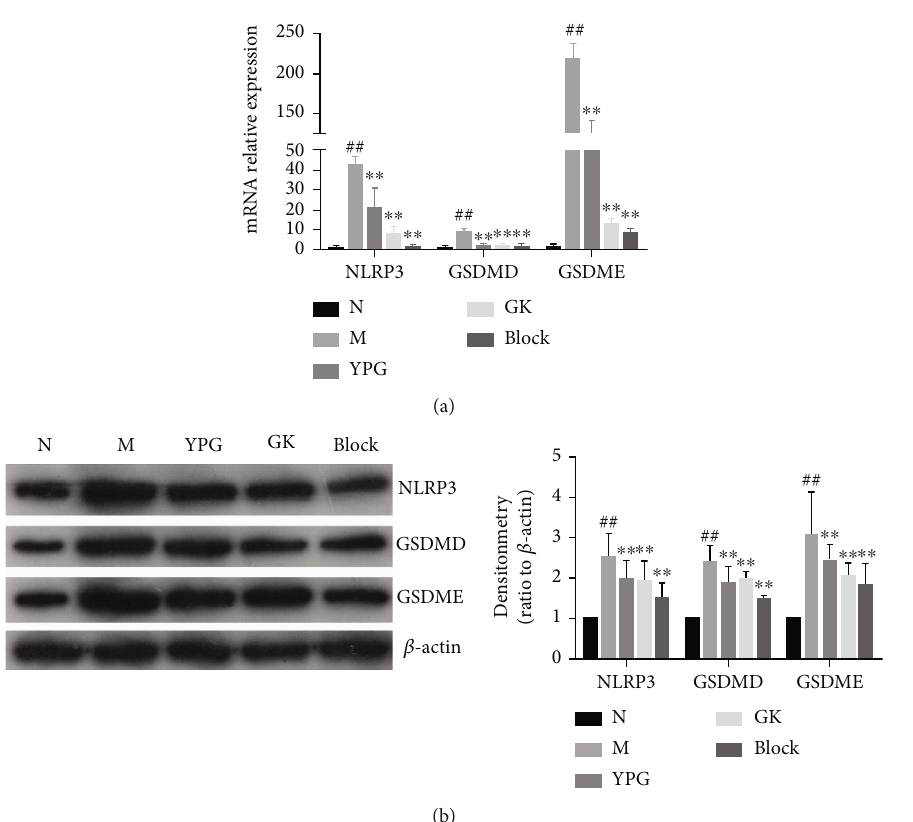
Figure 7: E ff ect of YPG on the expression of pyroptosis factor in BA rats. (a) mRNA levels of NLRP3, GSDMD, and GSDME were determined by real-time quantitative PCR. (b) The change in NLRP3, GSDMD, and GSDME protein expression was observed by western blotting. Notes: ## P < 0 : 01 compared with the normal group; ∗∗ P < 0 : 01 compared with the model